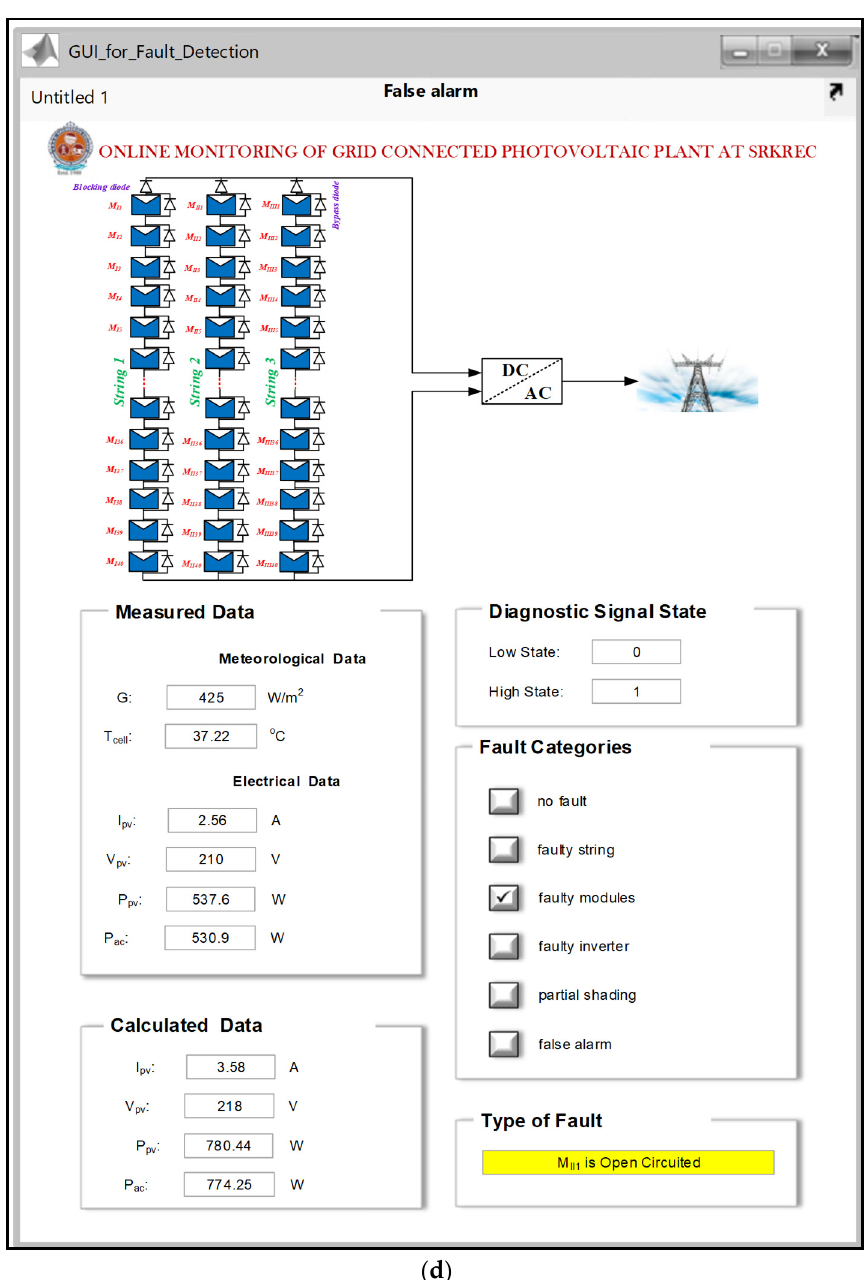
Figure 9. ( a ) Evolution of diagnostic signal during open-circuit fault condition; ( b ) measured PV current; ( c ) measured PV current; ( d ) faulty module observed in designed tool.